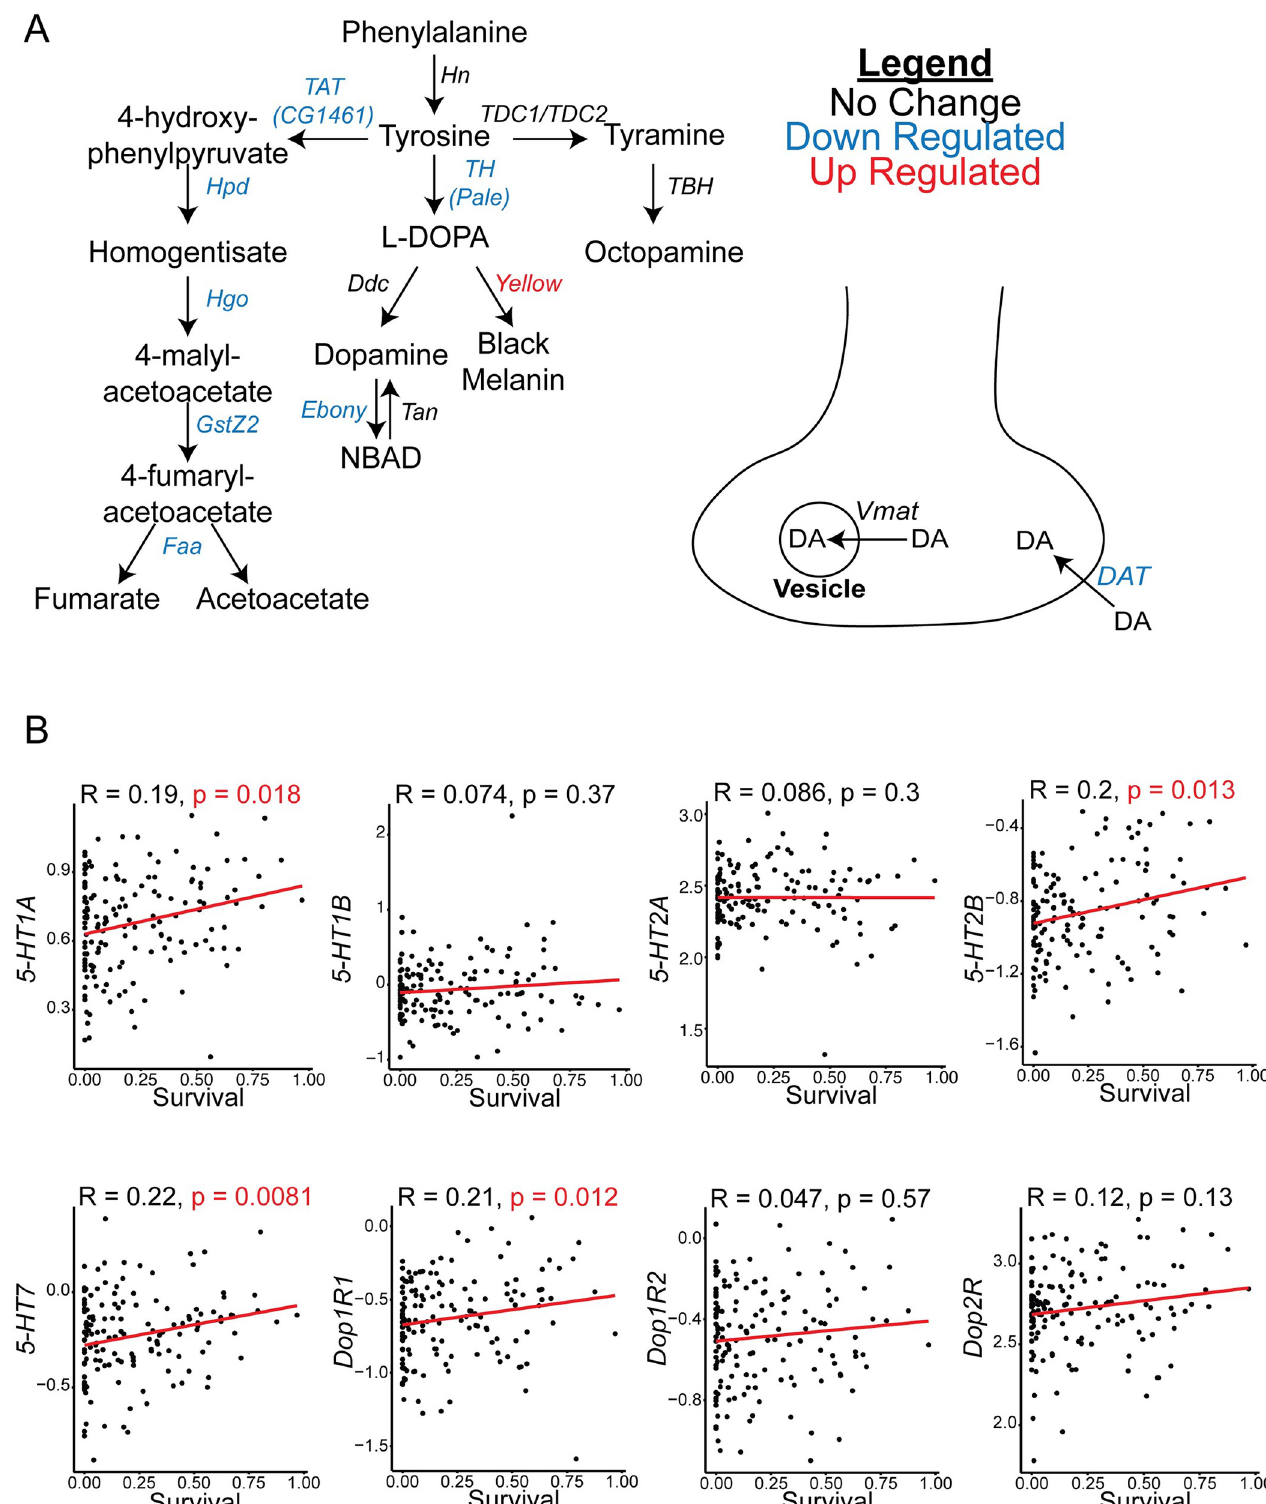
Fig 2. Prior studies implicate the serotonin and dopamine system in NGLY1 deficiency. A) Diagram showing the differentially expressed genes in the Drosophila dopamine biosynthesis and transport pathways. Gene expression data was from Tubulin > dNGLY1-RNAi whole flies reported in a previous study [12]. B) Spearman correlation analysis between survival upon knockdown of dNGLY1 [22] and gene expression of serotonin and dopamine receptors at baseline in the Drosophila Genetic Reference Panel